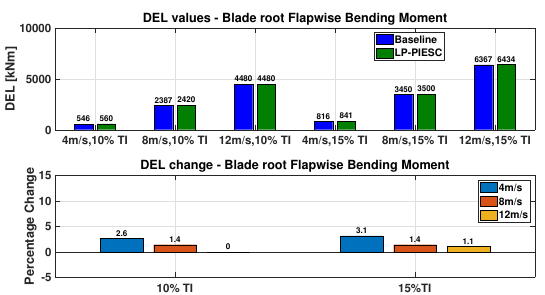
Figure 21. Blade-root flap-wise bending moment comparison: Baseline vs. LP-PIESC. Aggregate DEL values with baseline controller and LP-PIESC ( top ), percentage change in DEL ( bottom ) for time series from 300 s to 3000 s.